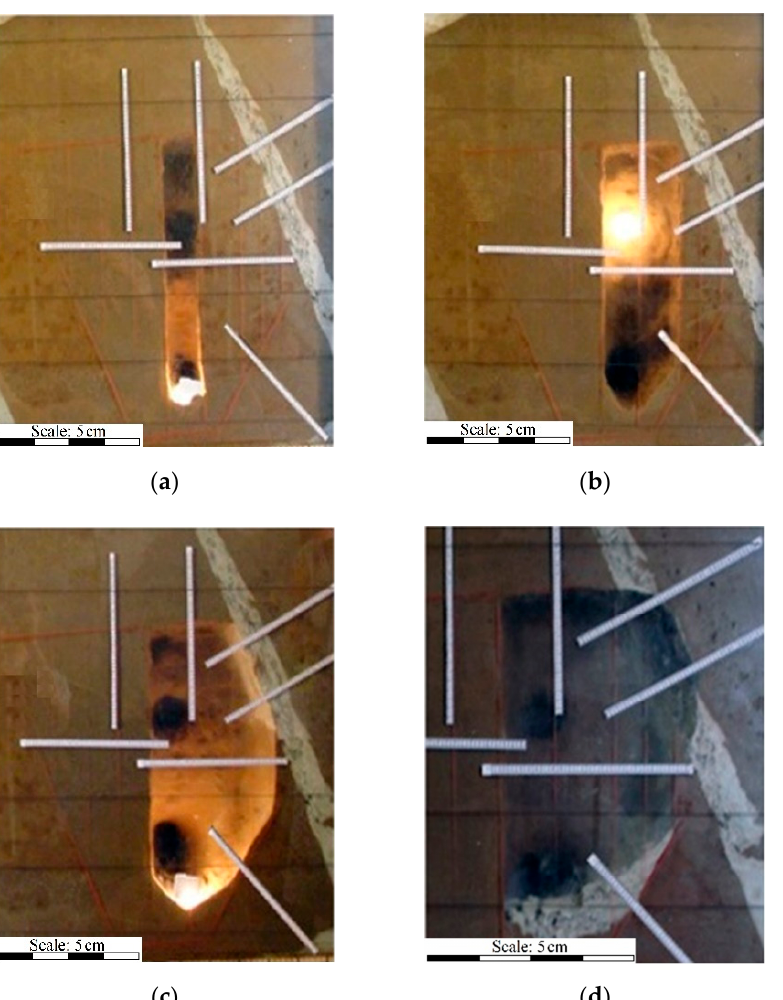
Figure 6. Modeling the stages of stope mining at the contact with hanging wall rocks: ( a ) stage 1; ( b ) stage 2; ( c ) stage 3; ( d ) stage 4.